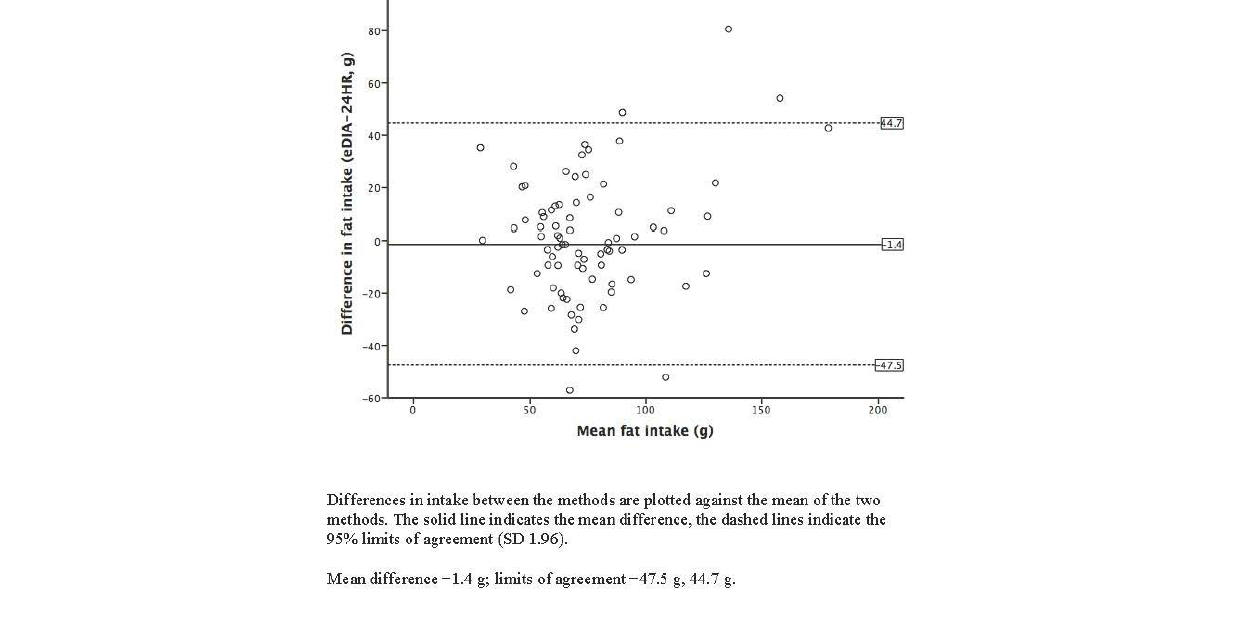
Figure 6. Bland-Altman plot of 24-hour dietary recalls (24HR) and electronic Dietary Intake Assessment (e-DIA) for fat